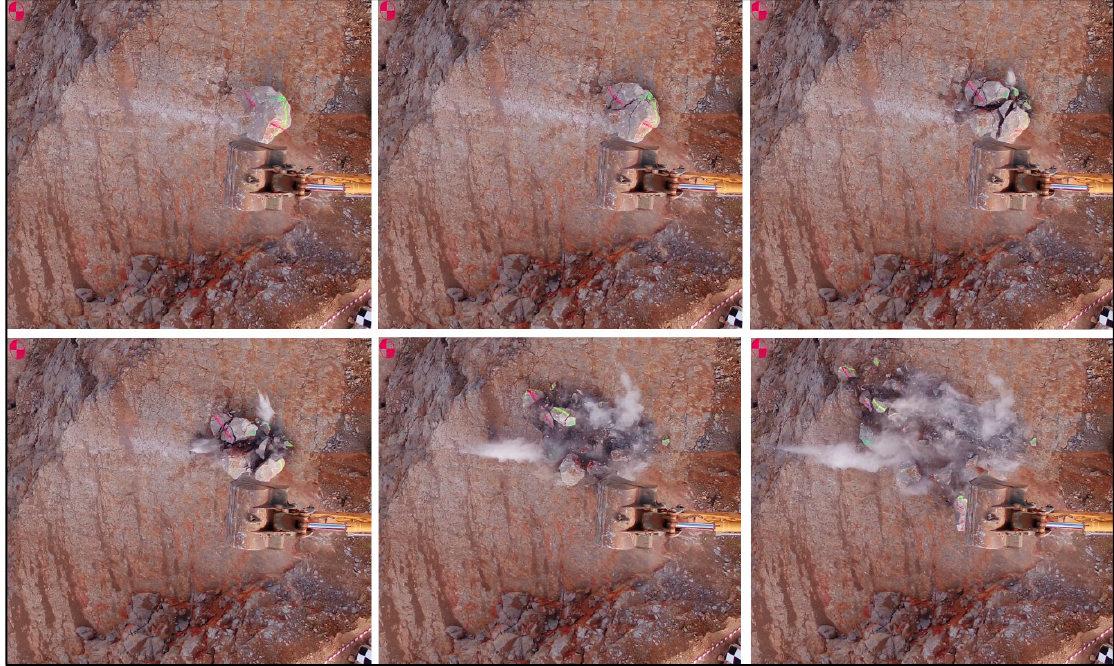
Figure 5. Sequence of frames extracted from a zenithal video recorded with a UAV during the test 4.